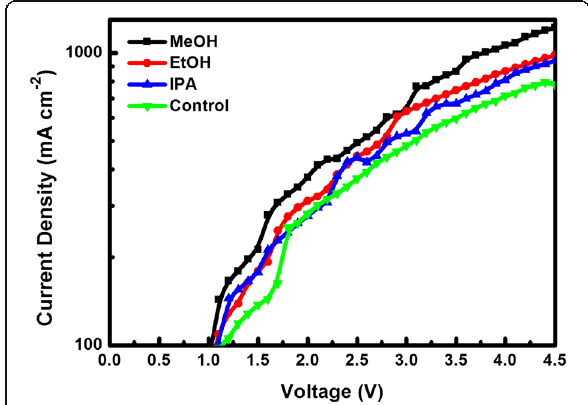
Fig. 3 Current density versus voltage curves (CD-V) of hole-only PeLEDs with and without alcohol solvent treatments